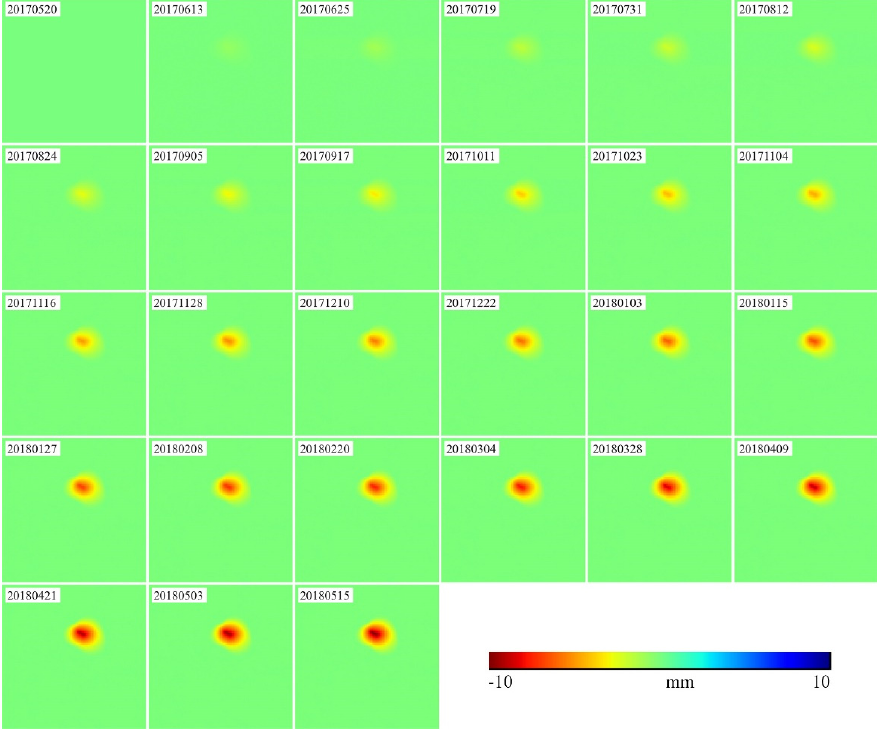
Figure 7. Time series deformation fields calculated by the pseudo-combination SBAS algorithm.